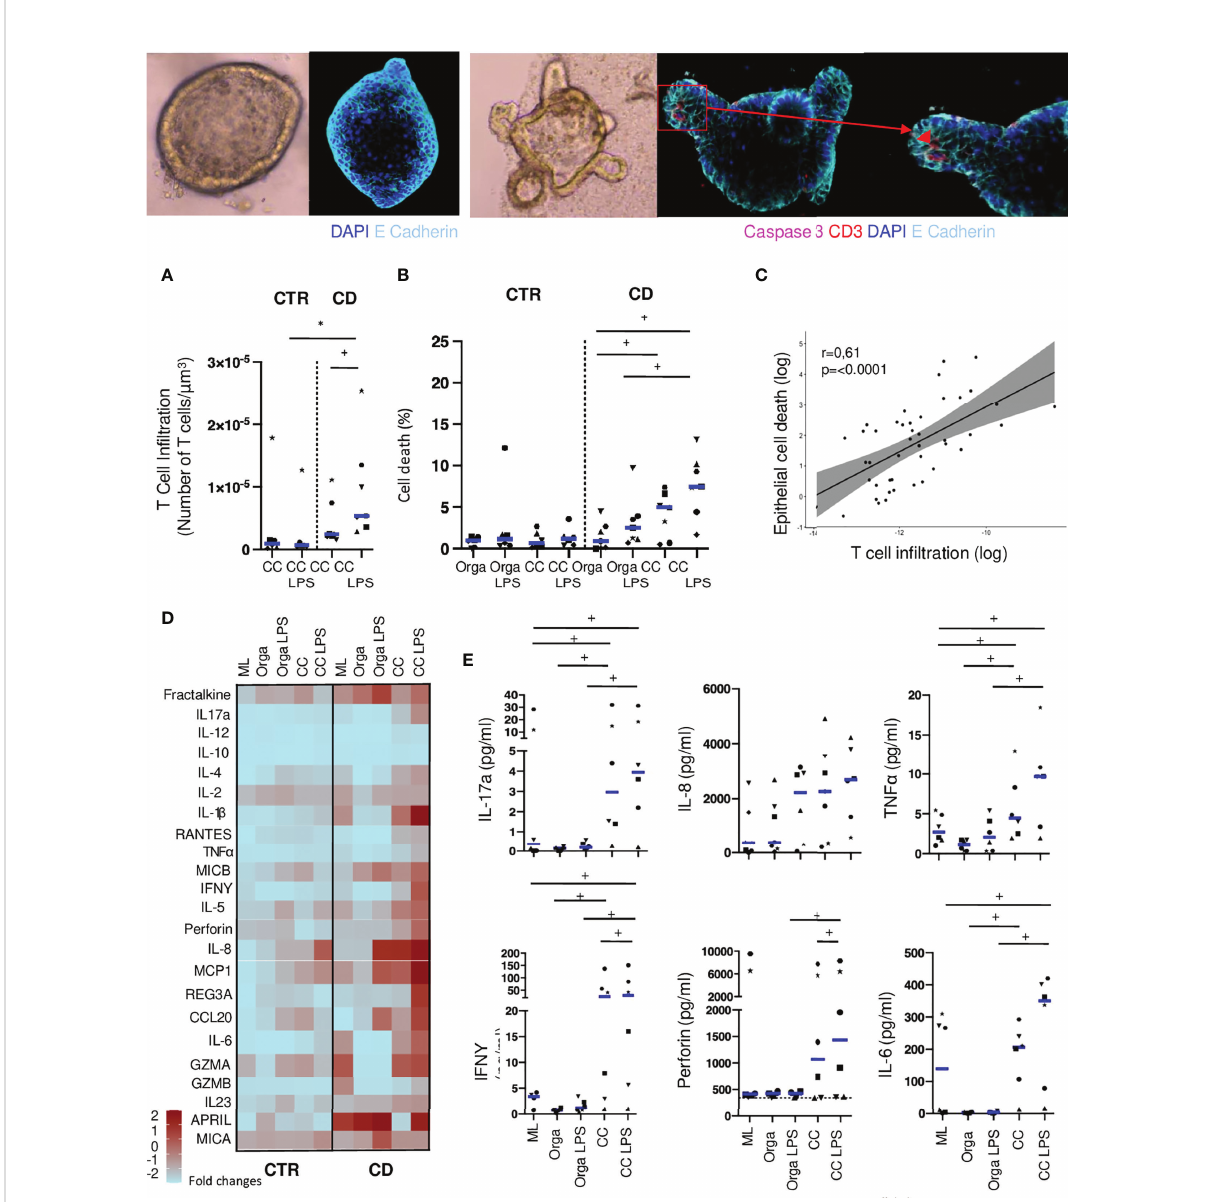
FIGURE 3 Autologous T cells from CD patients in fi ltrate organoids and induce epithelial cell death. (A) T cell in fi ltration in the organoids evaluated by the number of CD3 positive-cells in contact or in fi ltrating each organoid with or without LPS preincubation. Each dot corresponds to the median of the values obtained for organoids of a given patient. Each shape of point corresponds to a given patient. CTR: n=6, CD: n=7. (B) Organoid epithelial cell death evaluated by Caspase 3 fl uorescence area over organoid volume in organoids alone or cocultures with or without LPS preincubation. CTR: n=6, CD: n=7 (C) Correlation between T cell in fi ltration and epithelial cell death in coculture with LPS preincubation. Each dot corresponds to the absolute value obtained for an organoid. (D) Cytokine detection matrix in the supernatants. Each square represents the median value of the results obtained for each well of a given condition in the distinct patients. The color of each square stands for the level expression. CTR: n=6 CD: n=6. (E) Absolute values of cytokine quanti fi cation of 6 analytes (IL-17a, IL-8, TNFalpha, IFNgamma, Perforin and IL-6) in the supernatants from CD patients. Each dot corresponds to the absolute value obtained for a given condition. Each shape of point corresponds to a given patient. CC= Coculture, CD= Crohn ’ s Disease, CTR= Control, LPS= Lipopolysaccharide ML= Mucosal Lymphocytes, Orga= Organoid. +: p < 0.05 Wilcoxon paired Test, *p < 0.05 Mann-Whitney